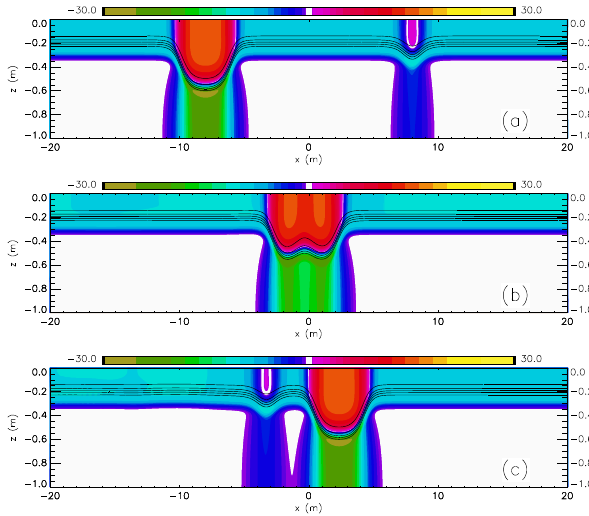
Fig. 4. Contour plots of the density field (solid lines) and horizontal velocity field (colours) for two interacting ISWs with initial APEs of 2.5 and 80Jm − 1 . Simulation is done in a reference frame mov- ing with the average propagation speed of the waves. The horizontal velocity field shown is that in a reference frame fixed with the far field fluid below the surface current. (a) Initial waves. (b) Waves at middle of the interaction ( t = 310s). (c) t = 400s. The white regions indicate regions where | u | < 0 . 0013ms − 1 .